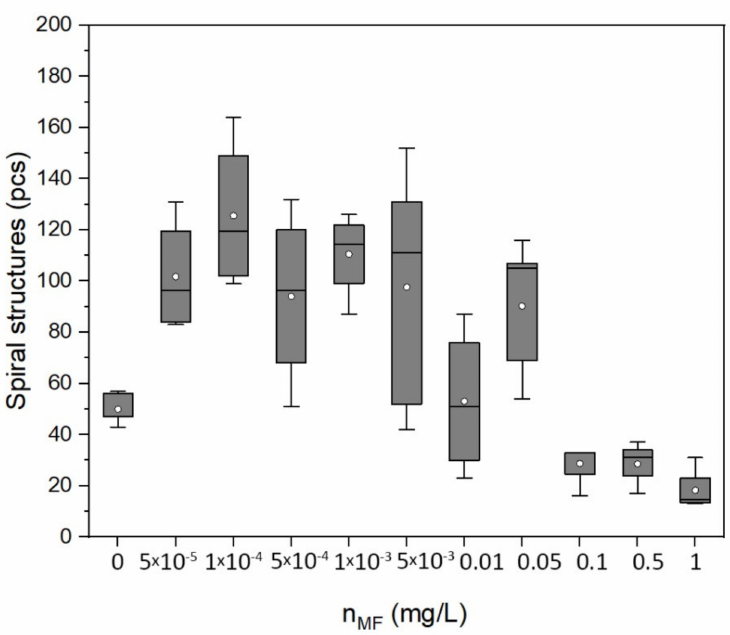
Figure 10. Dependence of the number of spiral structures on the concentration of MF in the albumin protein solution (quartile plots; point indicates mean